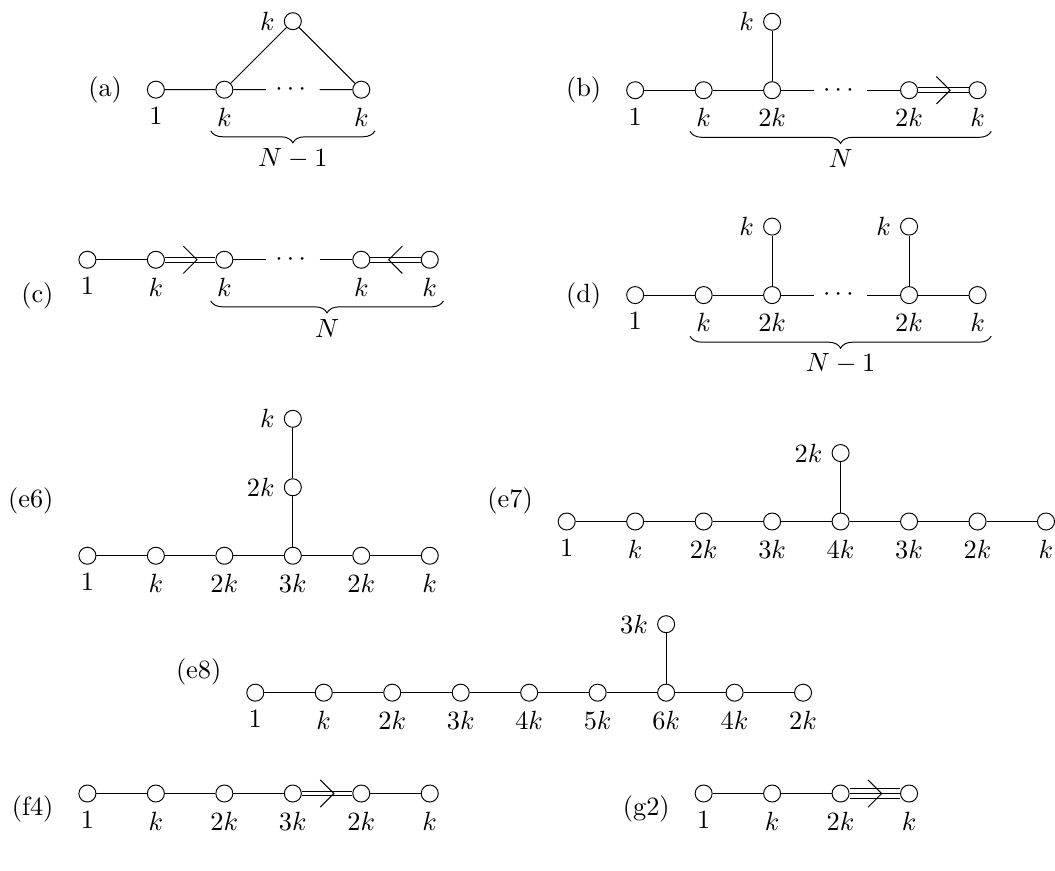
Figure 3. CFHM quivers Q k,G whose 3 d N = 4 Coulomb branch is M k,G [17]. We have: (a) G = SU( N ) , (b) G = SO(2 N + 1) , (c) G = Sp( N ) , (d) G = SO(2 N ) , (e6) G = E 6 , (e7) G = E 7 , (e8) G = E , (f4) G = F , (g2) G = G . (a)-(d) are 3d mirror duals to figure 8 4 2